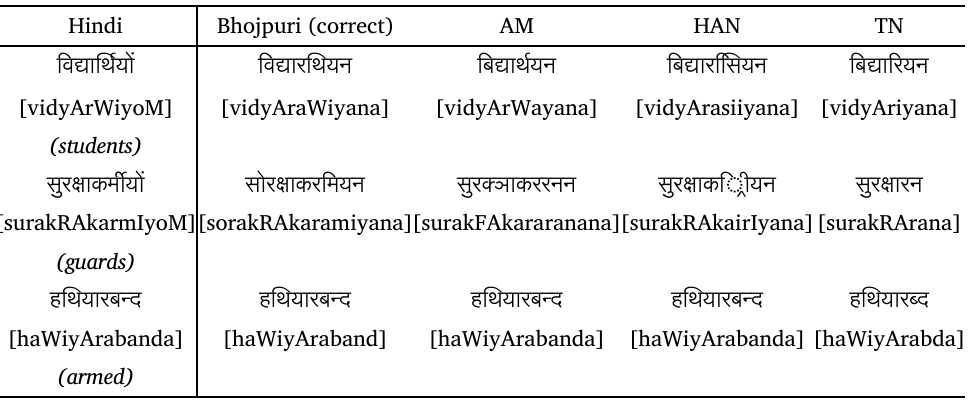
Table 12: Performance on long